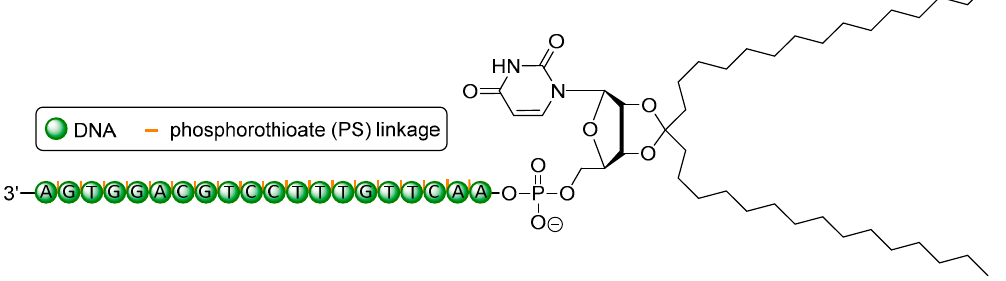
Figure 9. Structure of the ketal (2 ′ ,3 ′ - O -(16-hentriacontanylidene)) nucleolipid-conjugated ASO for the silencing of cancer-related expression of TCTP.